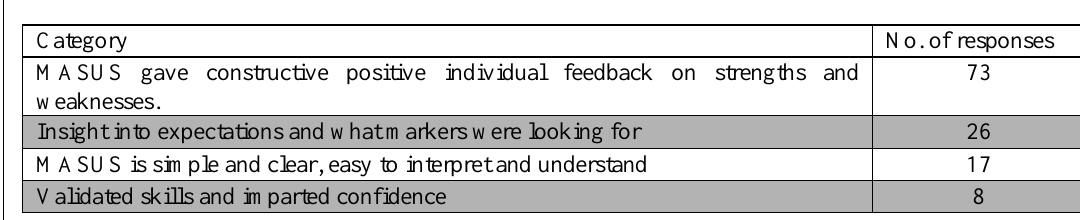
Table 4: Reasons for positive responses to